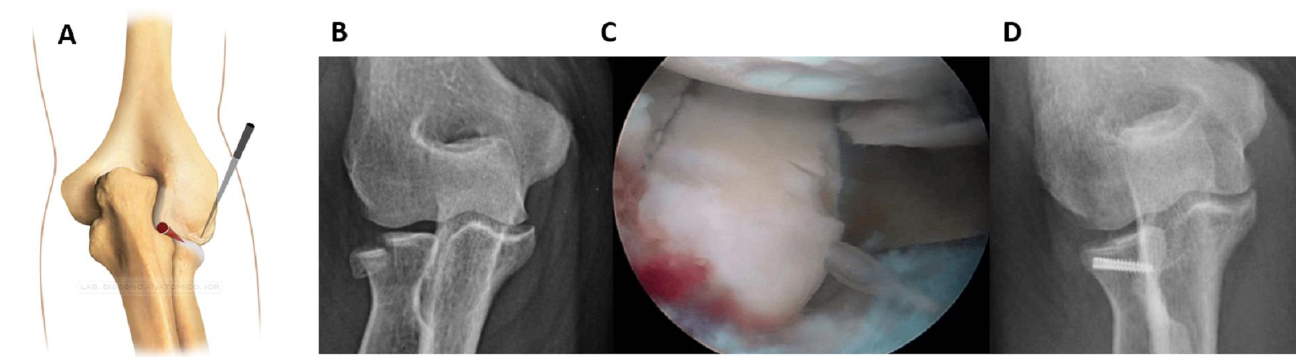
Figure 2. Fracture of lateral half of radial head that is fixed using the posterolateral working position; posterolateral and midlateral portals were created ( A ). From the superior view, the shaver and probe created the necessary space to reduce the fragment. ( B ): Pre-operative x-ray showing the fracture. ( C ): Intraoperative image of fracture fixation. ( D ): Control x-ray.